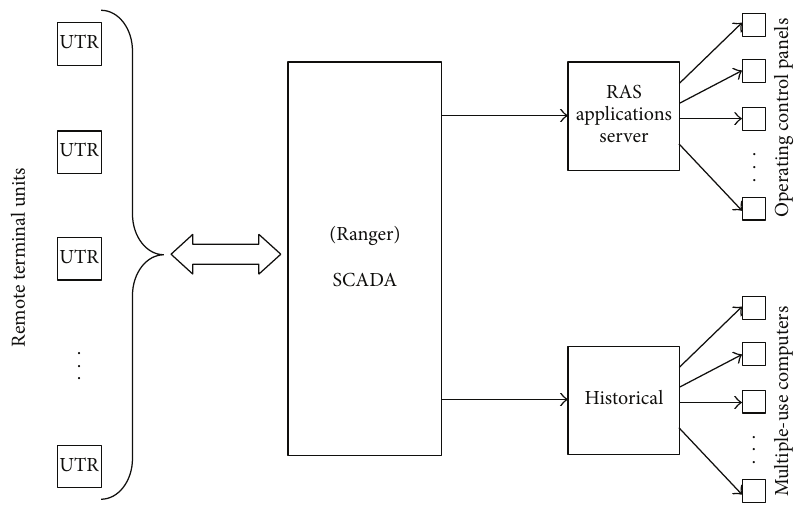
Figure 11: Data acquisition structure of the